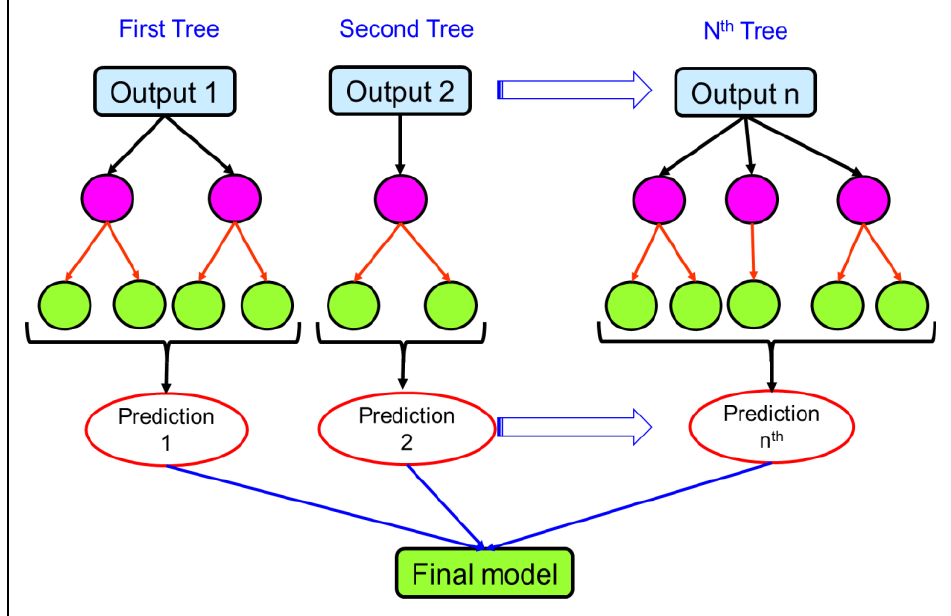
Figure 5. Schematics of BRT.